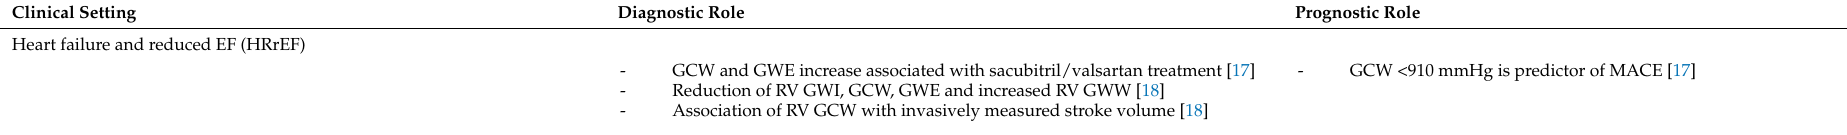
Table 2. Main clinical applications of MW